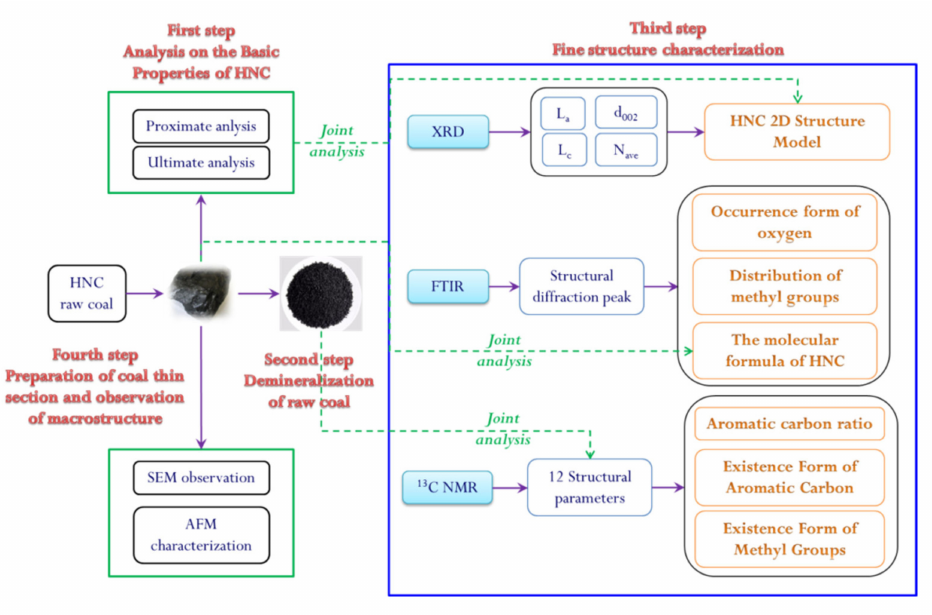
Figure 1. The analysis procedure chart of this